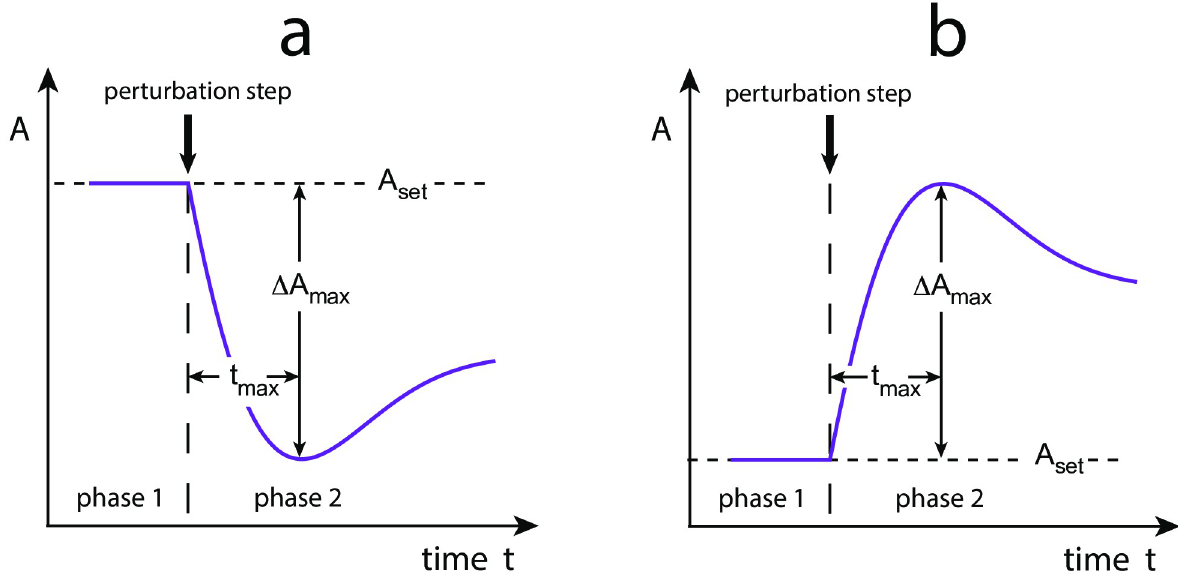
Fig 2. Idealized response kinetics of (a) inflow and (b) outflow controllers upon step perturbations. Indicated are the set-point of the controlled variable A , A , the maximum excursion of A , Δ A set